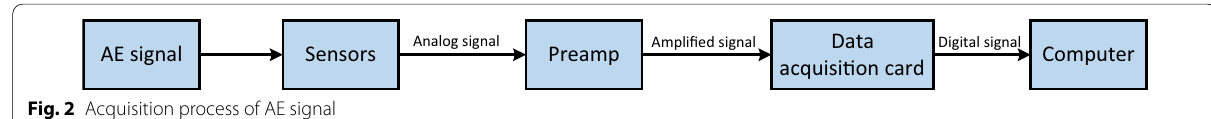
AE signal Sensors Fig. 2 Acquisition process of AE